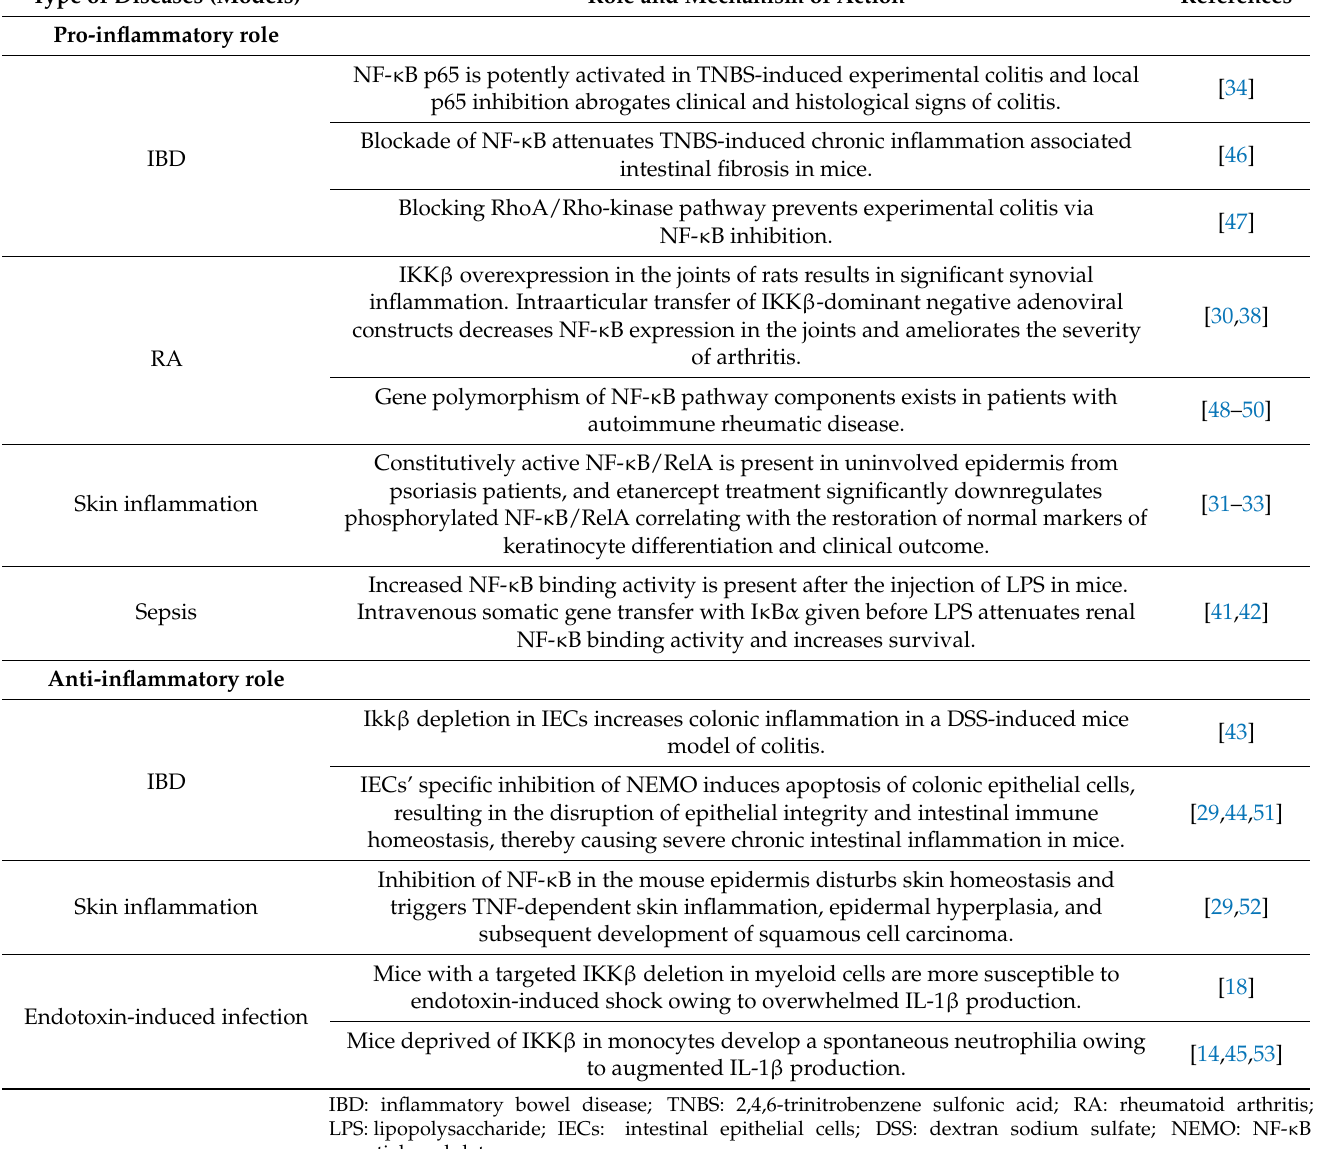
Table 1. Pro- and anti-inflammatory properties of NF- κ B in inflammatory diseases. Type of Diseases (Models) Role and Mechanism of